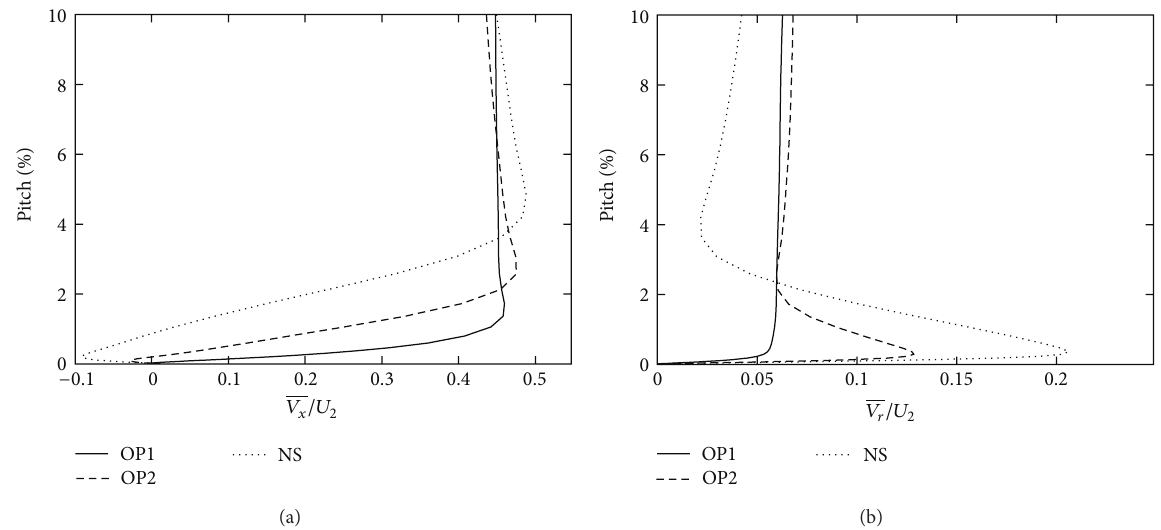
Figure 5: Time-averaged reduced axial velocity (a) and time-averaged reduced radial velocity (b), in the main blade suction side boundary layer, at 50% span, 2 mm downstream the leading edge.